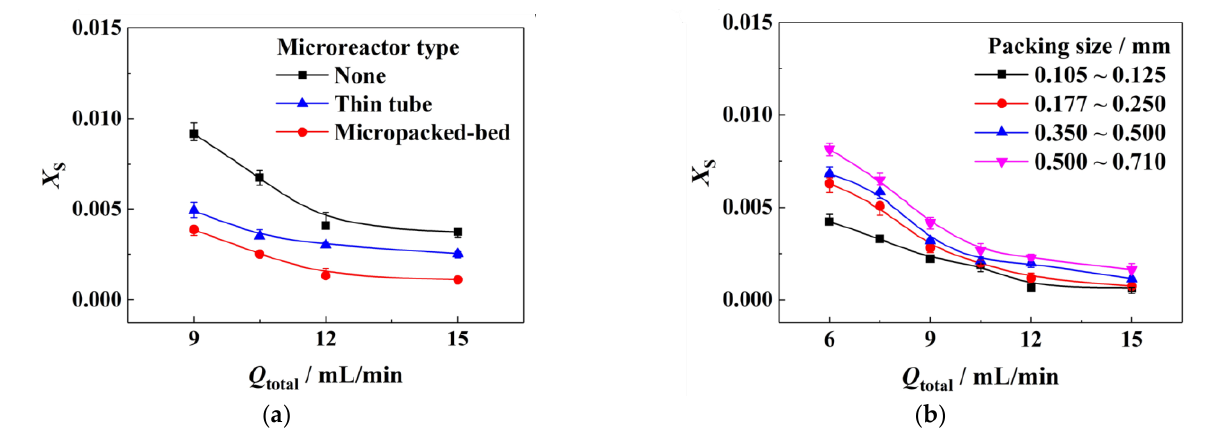
Figure 2. Flow rate profiles of the micromixing performance under various conditions: ( a ) different reactor types; ( b ) different packing sizes. Reference conditions: micromixer, 0.25 mm of I.D.; connecting pipe, 0.5 mm of I.D., 5 cm of length; microreactor, 0.5 mL of empty volume; thin tube, 0.75 mm of I.D., 0.5 mL of empty volume; Q A : Q B = 5:1; μ B = 1 mPa·s.; ( a ) packing size, 0.177~0.250 mm, and μ A = 25 mPa·s; ( b ) μ A = 10 mPa·s.